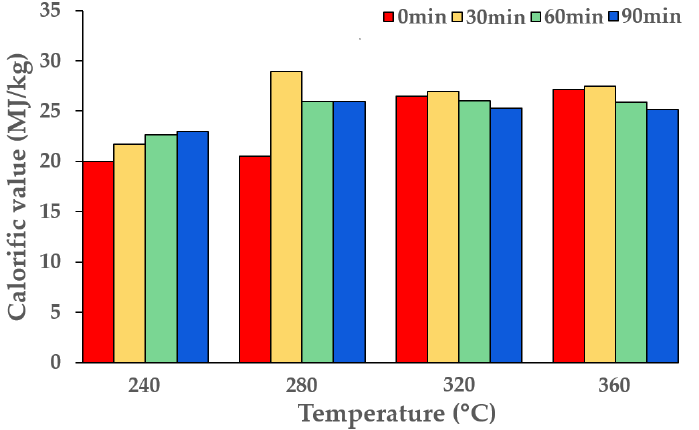
Figure 4. Variations on calorific values of torrefied RH products produced at 280–360 °C for holding 0–90 min.